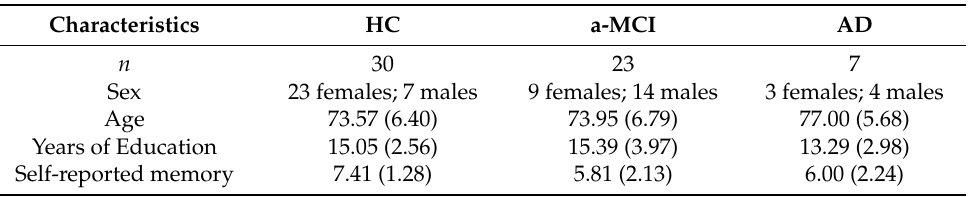
Table 1. Demographic characteristics by